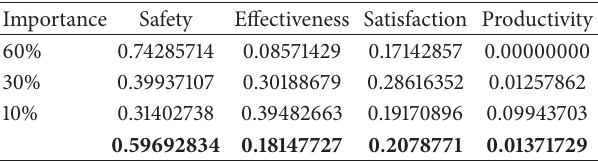
Table 7: Normalized value of the results of Search Types 1, 2, and 3, respectively, for